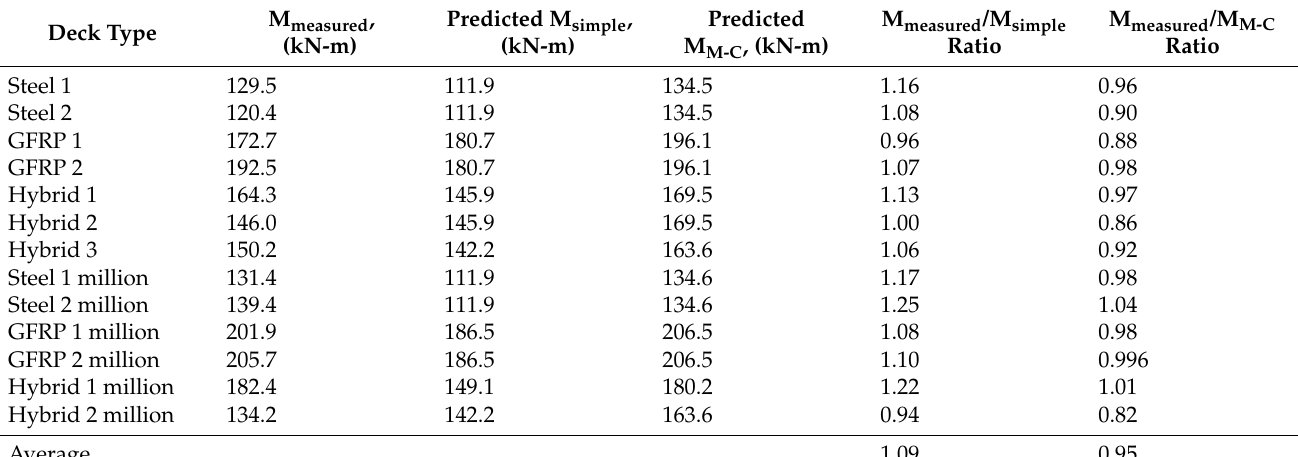
Table 6. Summary of measured and predicted flexural